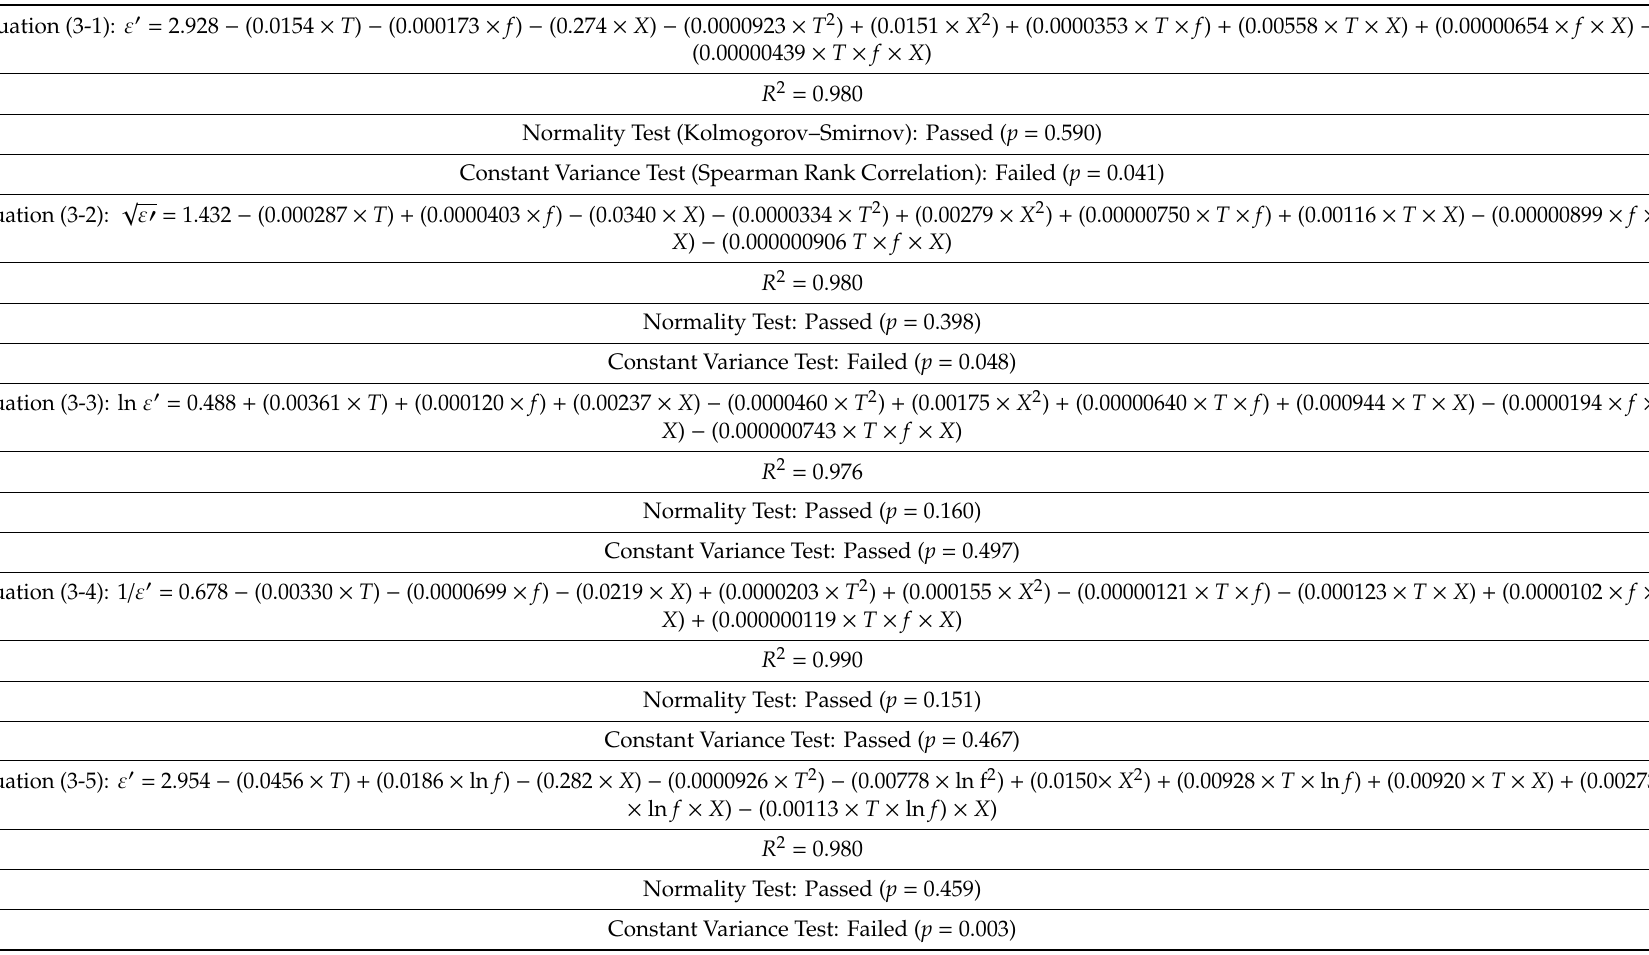
Table 3. The relationship between the dielectric constant and the influencing factors and statistical criteria established by regression analysis for egg white